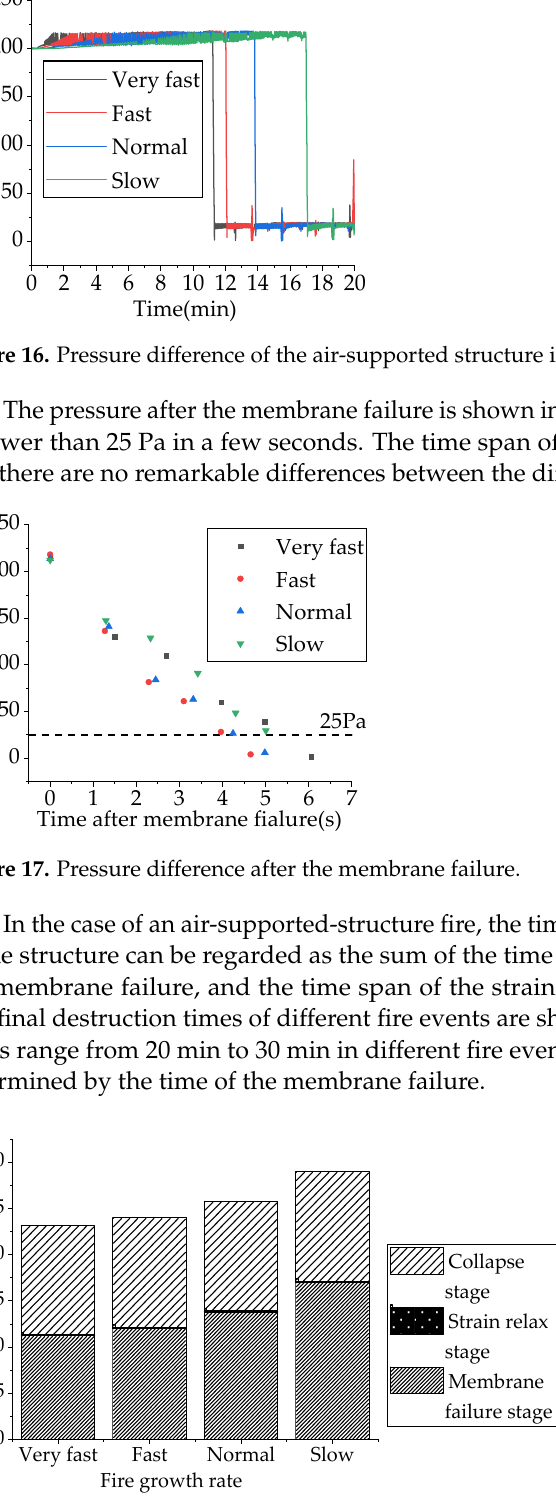
Figure 18. Destruction time of air-supported structures in different fire cases.